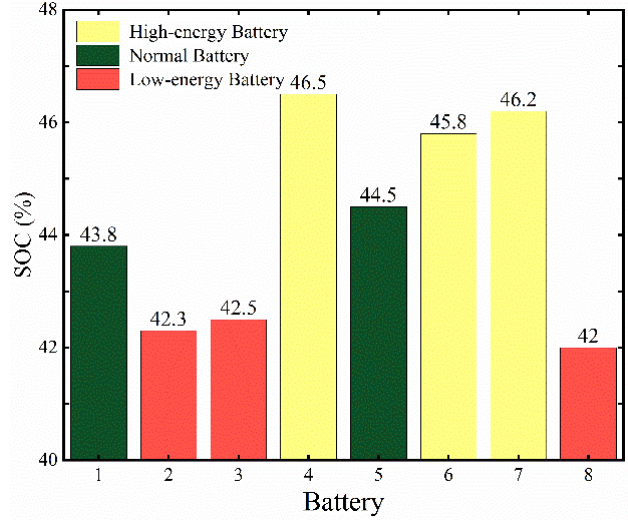
Figure 19. Battery pack energy state distribution.